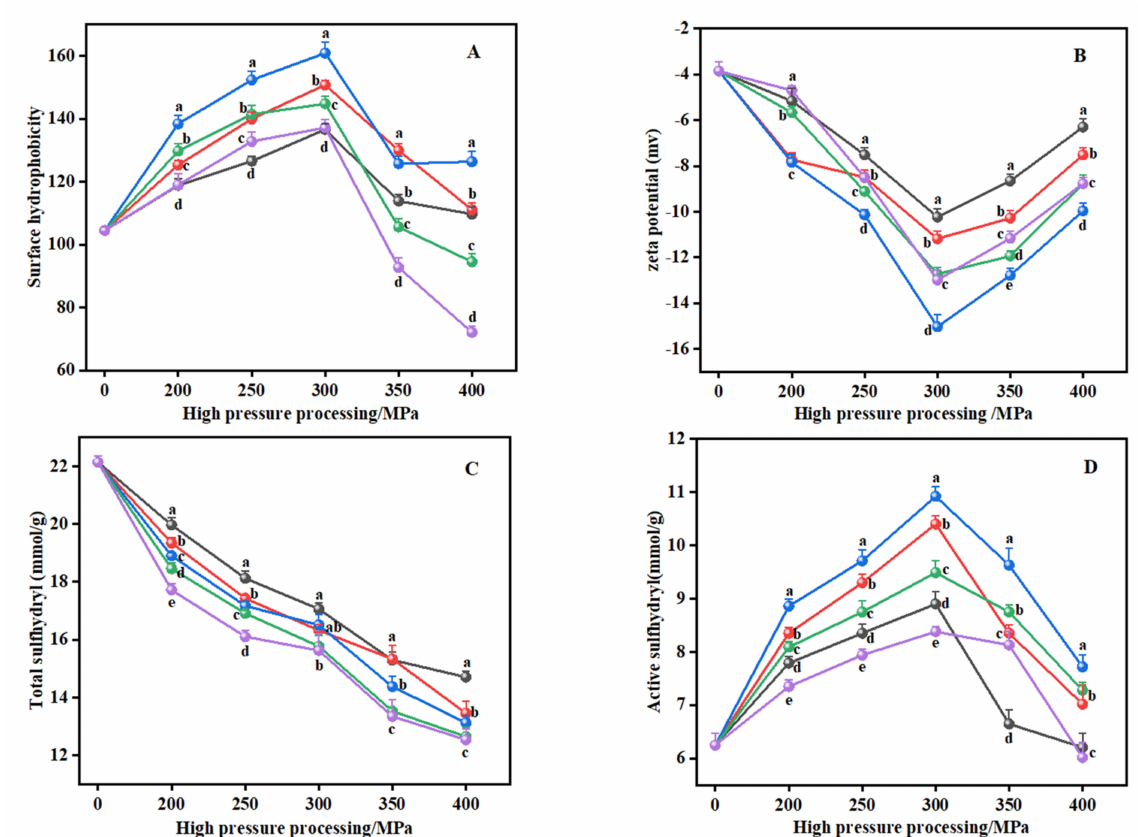
Figure 3. The effect of high hydrostatic pressure processing on the hydrophobic interactions ( A ), electrostatic interactions ( B ), and disulfide bonds contents ( C , D ) of cowhide collagen. The lowercase letters (a − e) indicate that different high − pressure durations have significant differences among the same pressure. High pressure 5 min ( • ); high pressure 10 min ( • ); high pressure 15 min ( • ); high pressure 20 min ( • ); high pressure 25 min ( •